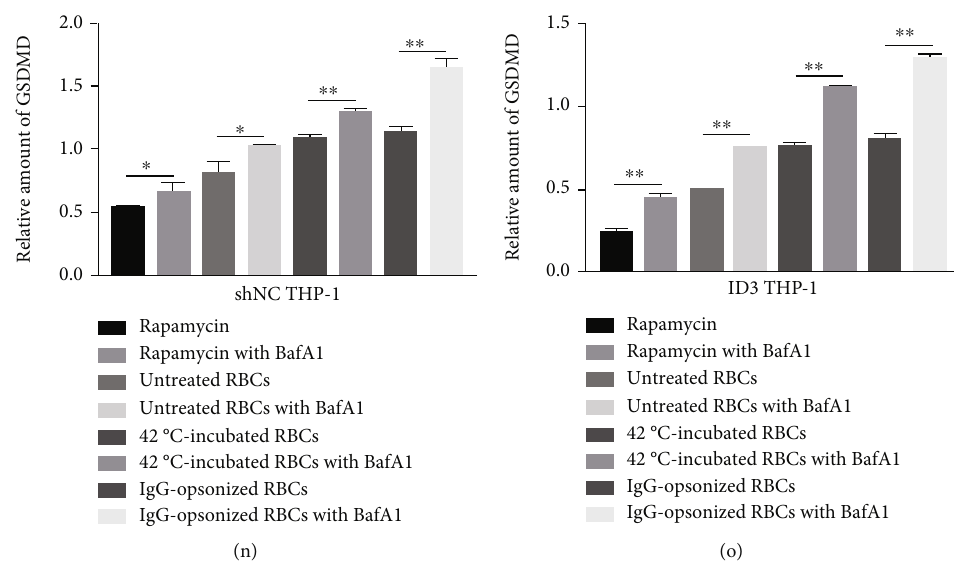
Figure 6: NLRP3 and GSDMD determined via immunoblotting. (a) The expressions of NLRP3 and GSDMD determined via immunoblot. (b) Histograms of the NLRP3 activation state of three di ff erent THP-1 cells after receiving the same stimulation in nine groups. (c) Relative quantity histograms of GSDMD of three di ff erent THP-1 cells after receiving the same stimulation in nine groups. (d) – (f) Histograms of the NLRP3 relative amounts of wild-type, shNC, and ID3 THP-1 cells after phagocytosis of erythrocytes. (g) – (i) Regulatory e ff ect of BafA1 on NLRP3 expression. (j) – (l) Histograms of the GSDMD relative amounts of wild-type, shNC, and ID3 THP-1 cells after phagocytosis of RBCs. (m) – (o) Regulatory e ff ect of BafA1 on GSDMD expression. ∗ p < 0 : 05 , ∗∗ p < 0 : 01 , and ns: not signi fi